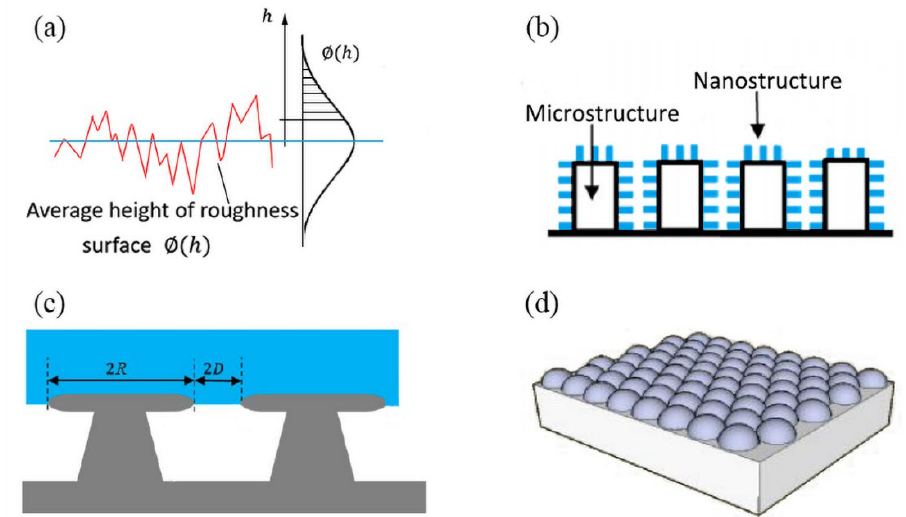
Figure 3. The schematic diagram of microstructures model. ( a ) Roughness model: assuming that the height of rough surface profile obeys Gaussian distribution. Reprinted with permission from Ref.